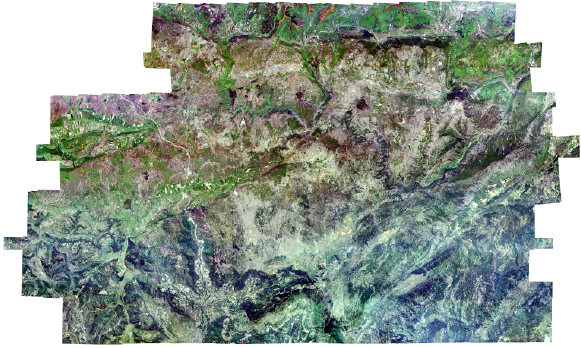
Figure 15. Our final